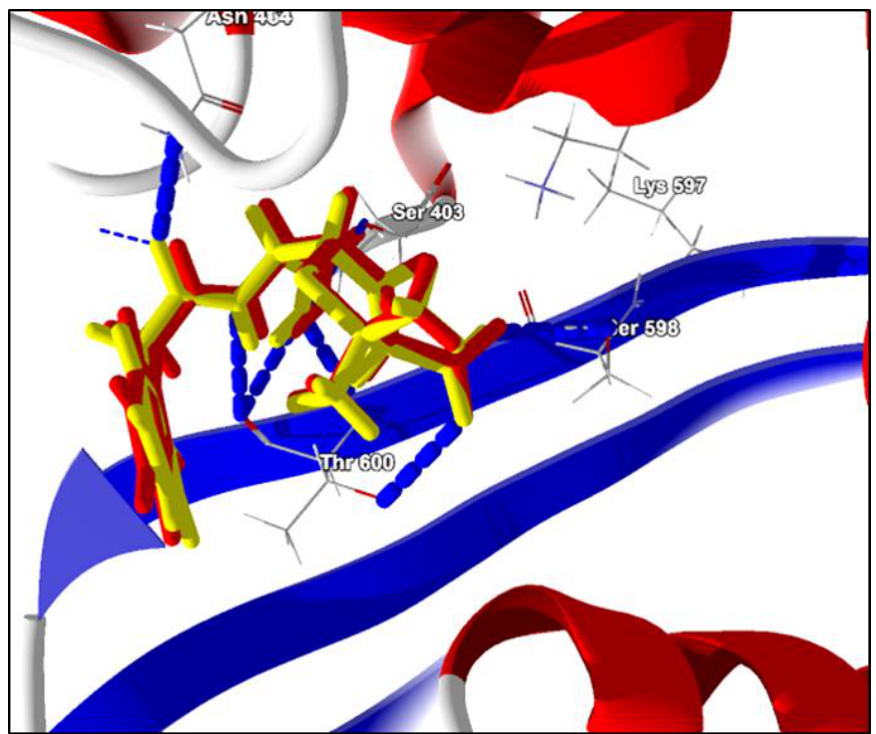
Figure 1. Overlapping a Protein Data Bank (PDB) ligand (Open Form, Penicillin G) with the best redocking conformation. Red: PDB binder. Yellow: conformation of the ligand after redocking. Blue-dotted: hydrogen bonding interactions.